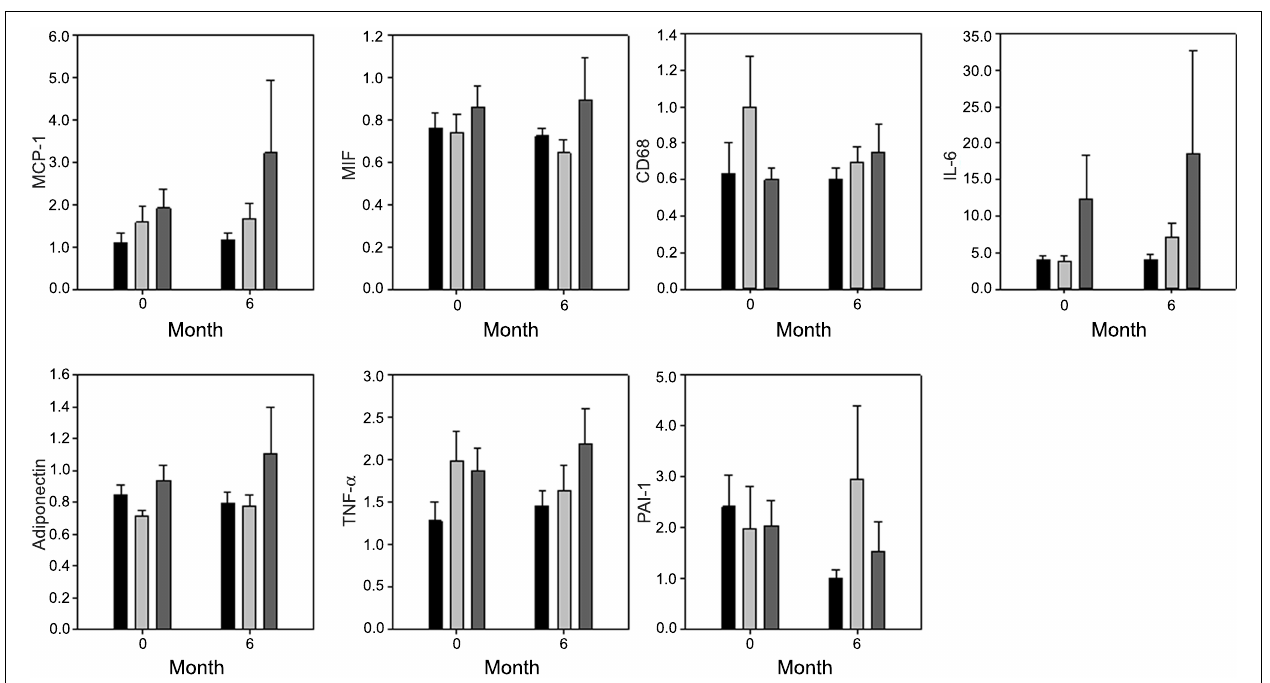
FIGURE 2 | Effect of a 25% energy deficit by diet (CR) or diet in conjunction with exercise (CR + EX) on the adipose tissue gene expression of adipokines. Gene expression shown normalized to cyclophilin B . Black bar: Control group; light gray bar: CR group; dark gray bar: CR + EX group. Data are mean ±